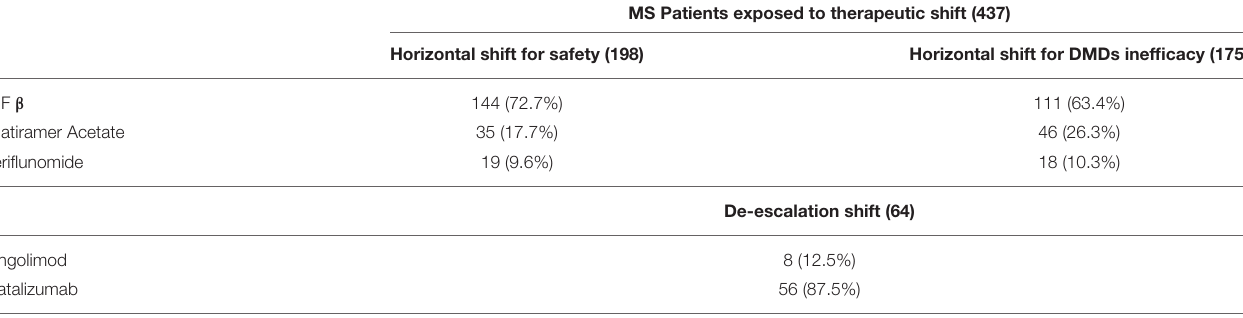
TABLE 3 | ARR before and after 24 months of DMF (340MS patients).